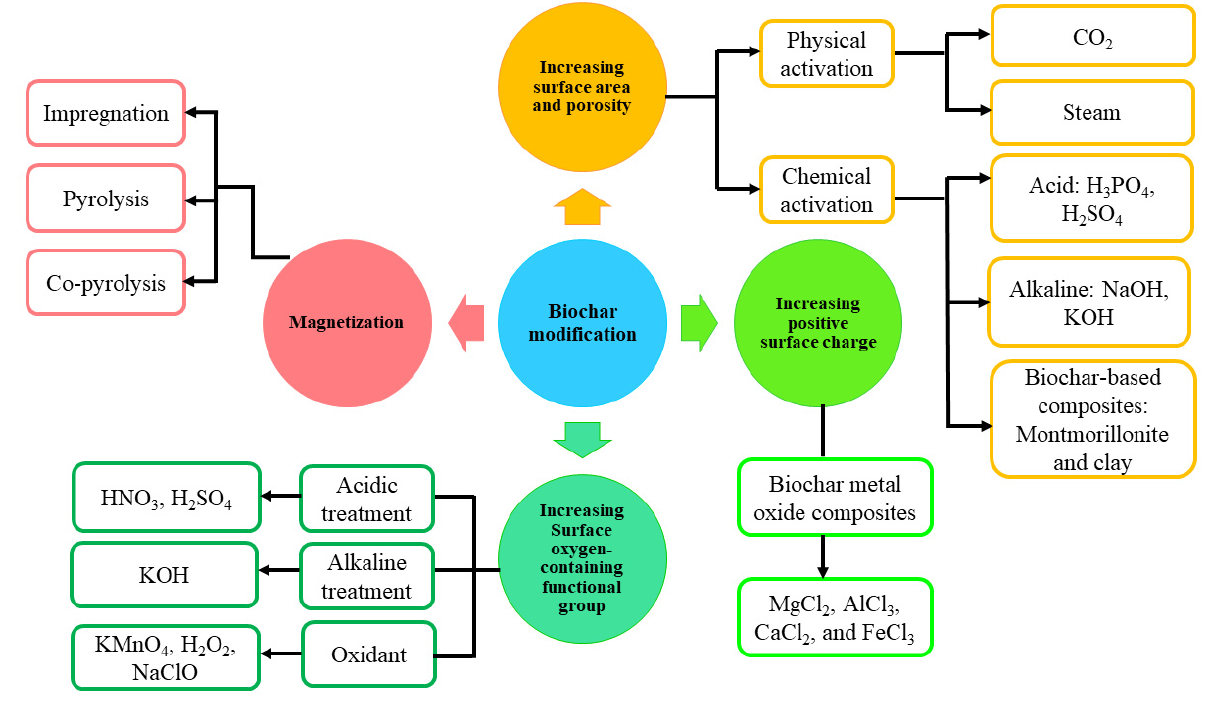
Figure 4. Modification and classification of engineered biochar.